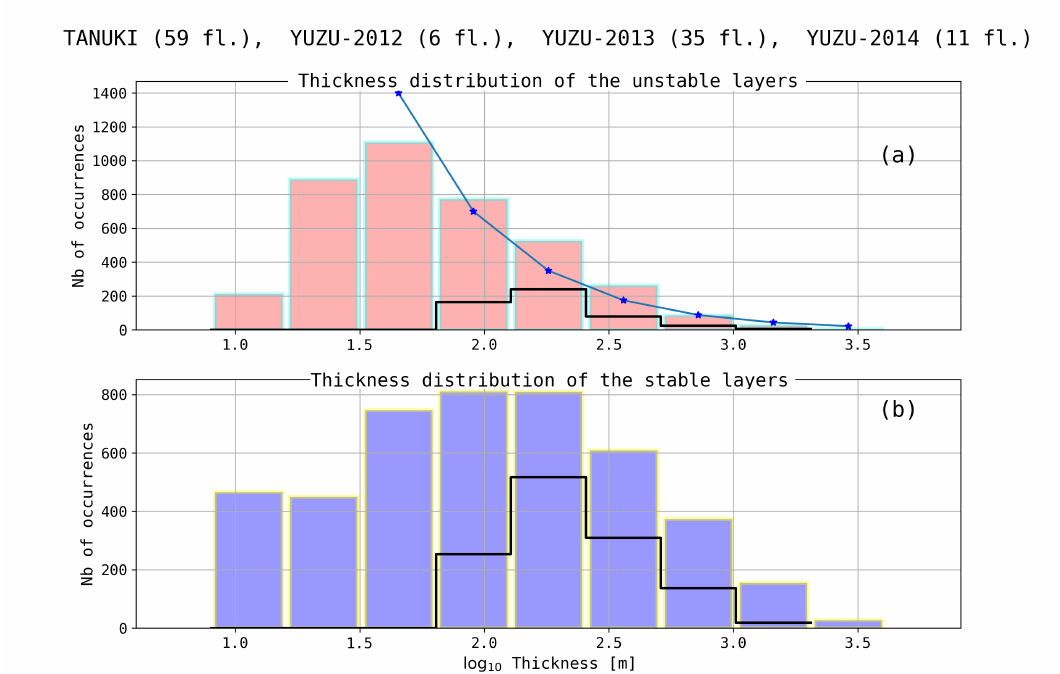
Figure 3. ( a ) Histogram of the unstable layers thicknesses. The black stair-like histogram corresponds to the layers thicker than 200 m from the least noisy profiles. ( b ) Histogram of the thicknesses of the calm (stably stratified) layers. Again, the black stair-like histogram shows the histogram of the selected layers ( > 200 m from the least noisy